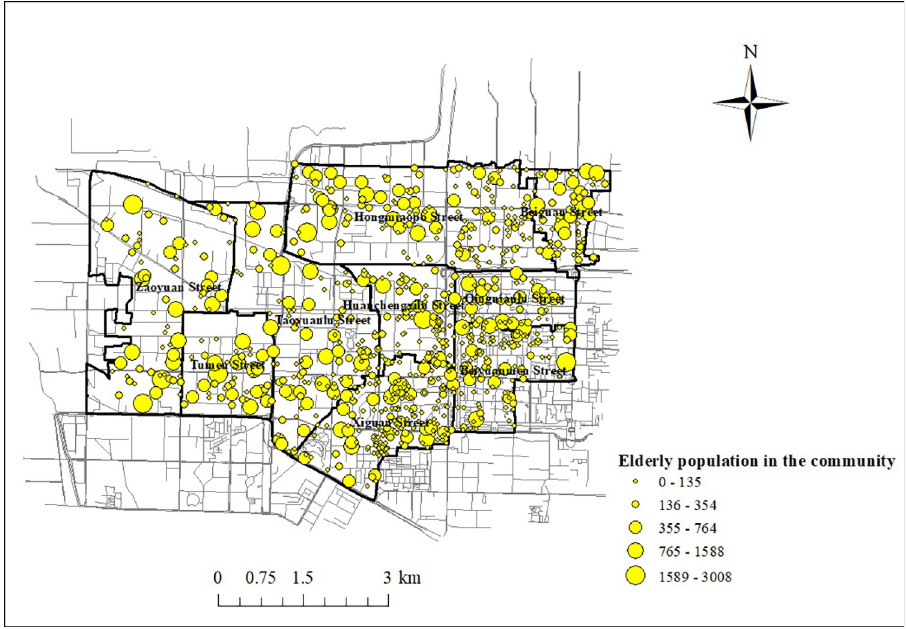
Fig 4. Spatial distribution of elderly population in the community. (https://www.openstreetmap.org/relation/ 3226093).